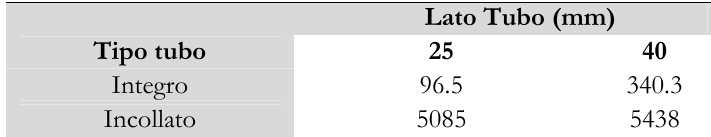
Lato Tubo (mm) Tipo tubo 25 40 Integro 96.5